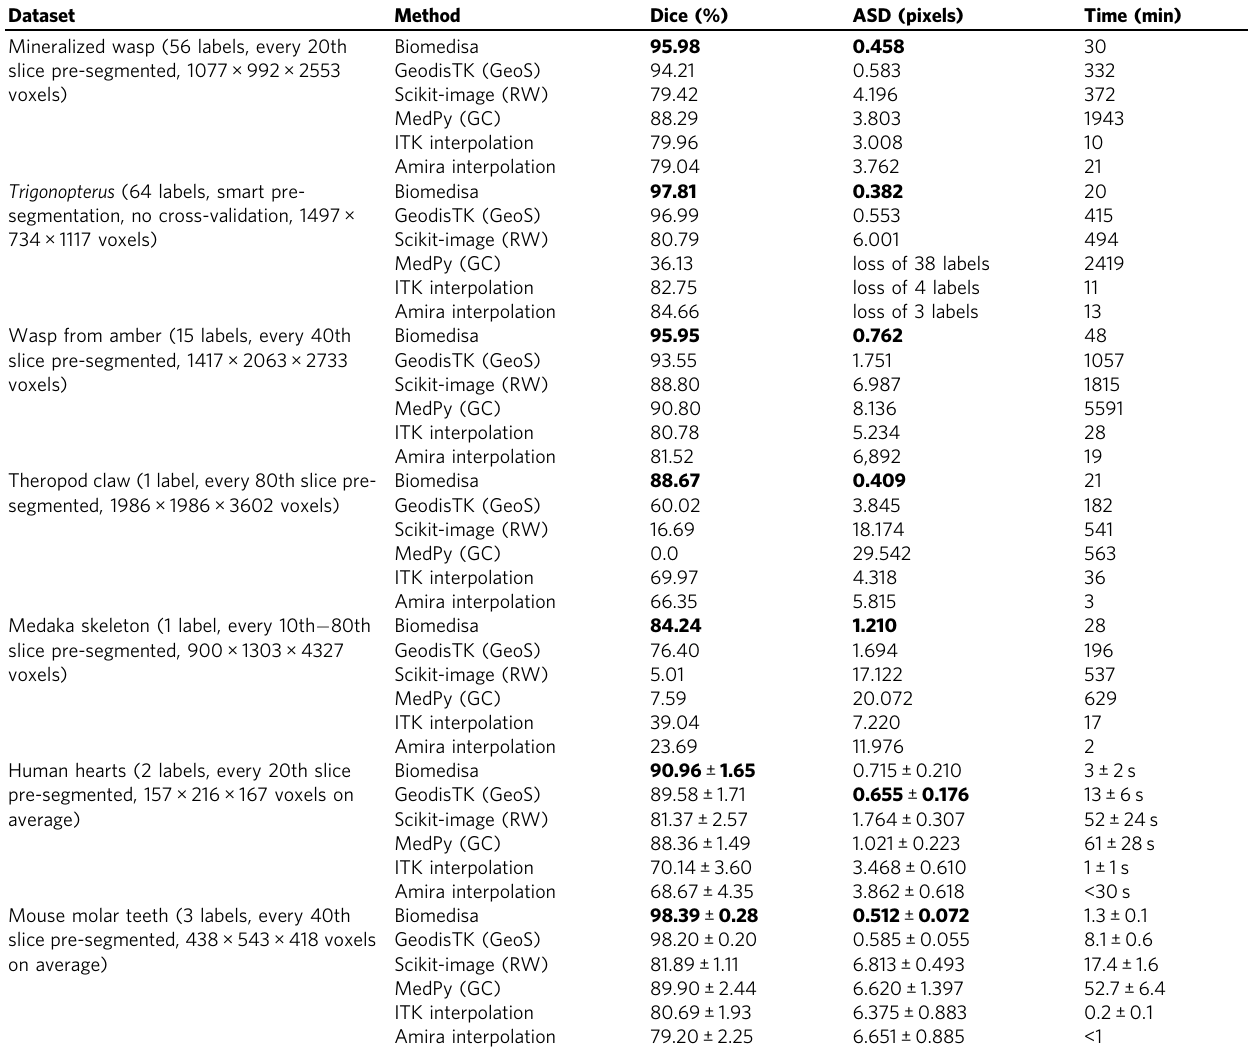
Table 1 Quantitative comparison of different semi-automatic segmentation tools for the segmentation of different datasets.